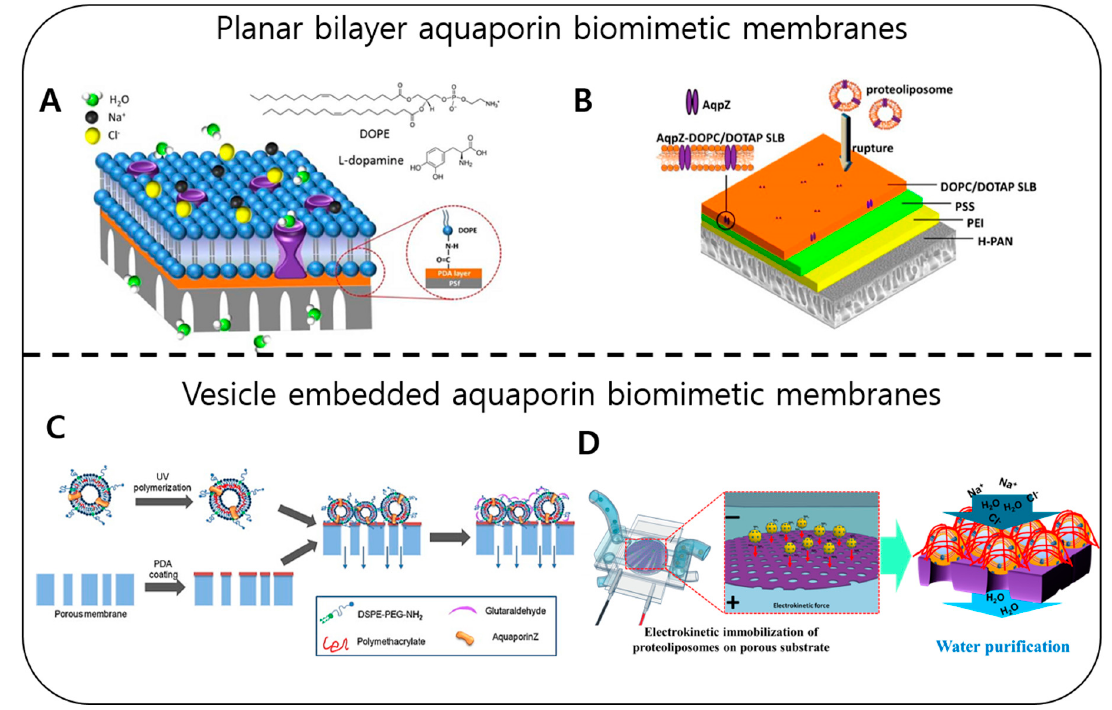
Figure 11. Shows the fabrication schemes of aquaporin biomimetic membranes. ( A ). Planar bilayer membrane fabrication using chemical conjugation. The bilayer attachment was performed by covalent bonding between the substrate and the lipid bilayer [195]. (Reproduced with the permission of Ding et. al, J. Mater. Chem. A, 2015, Copyright© 2015 Royal Society of Chemistry) ( B ). Vesicle rupture on the functionalized substrate. The bilayer was formed by rupturing the vesicles on the polyelectrolyte functionalized substrate [196]. (Reproduced with the permission of Wang et. al, Environ. Sci. Technol . 2015, Copyright© 2015 American Chemical Society) ( C ). Vesicle embedding using pressure. Vesicles were immobilized by applying negative pressure to the pores of membranes [197]. (Reproduced with permission from Sun et. al, Colloids Surf. B , 2013, Copyrights© 2013 Elsevier) ( D ). Vesicle embedding using electrokinetic force. Under an applied electric current, the vesicles were immobilized on the voids of a solid substrate [16]. (Reproduced with permission from Fuwad et. al, Desalination , 2019, Copyrights© 2019 Elsevier).